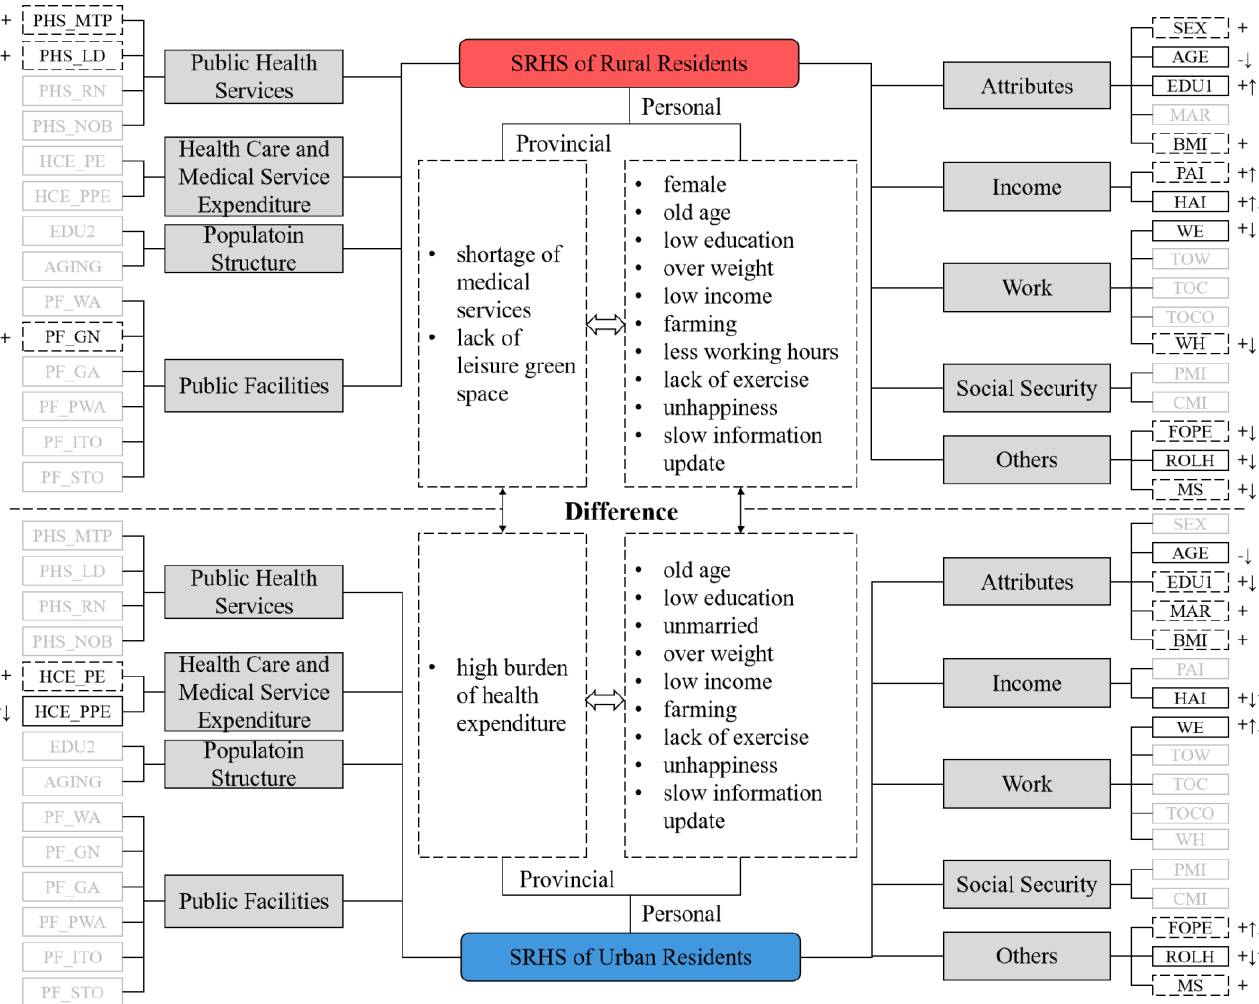
Figure 4. The comparison of the impact mechanism of the self-rated health status of urban and rural residents. Different types of box styles represent different influences: a solid line box with a significant impact all time; a dash line box with a significant impact in some years; an almost invisible box with no impact. The symbol “+” indicated a positive impact, and the symbol “ - ” indicated a negative impact. The symbol “ ↑ ” indicated the influence was gradually enhanced, and the symbol “ ↓ ” indicated the influence was gradually weakened.